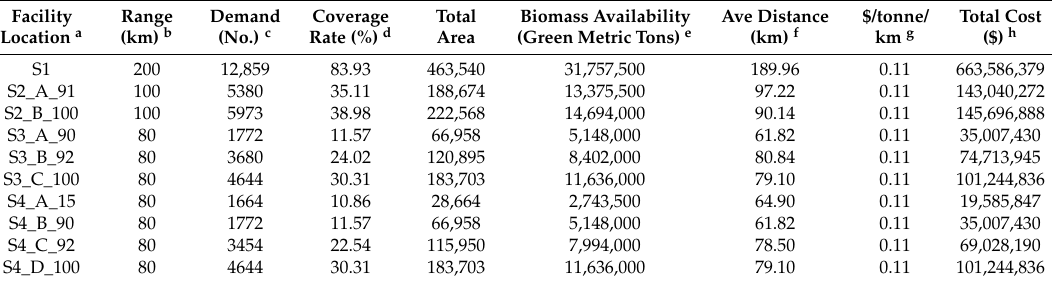
Table 4. Estimated transportation cost of biomass feedstock.